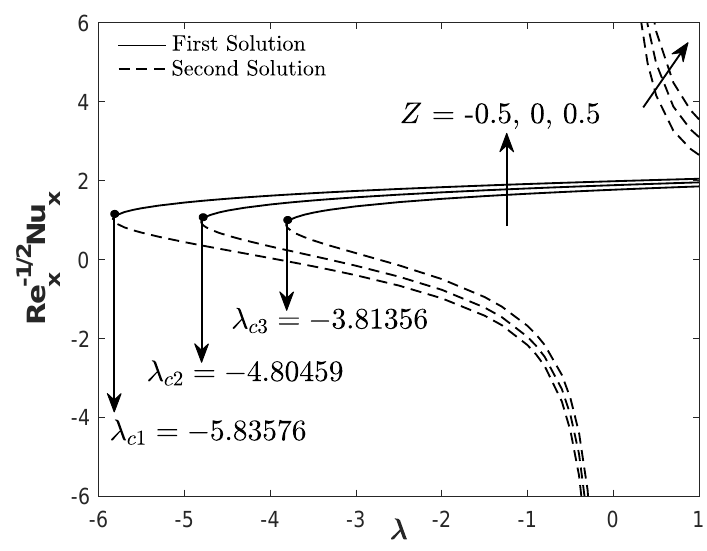
Figure 6. Re x − 1/2 Nu x towards λ when φ 2 = 0.005 and d = 0.5 with various Z .